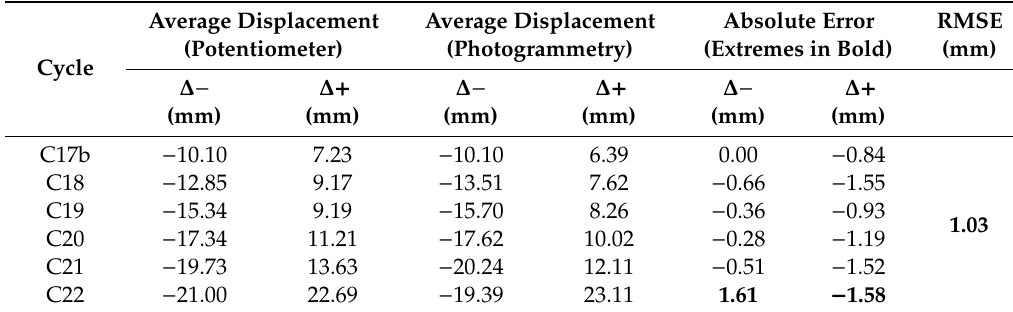
Table 9. Absolute errors obtained for the comparison between the average values of the peaks captured by target 1199 and sensor P3 after outlier removal.